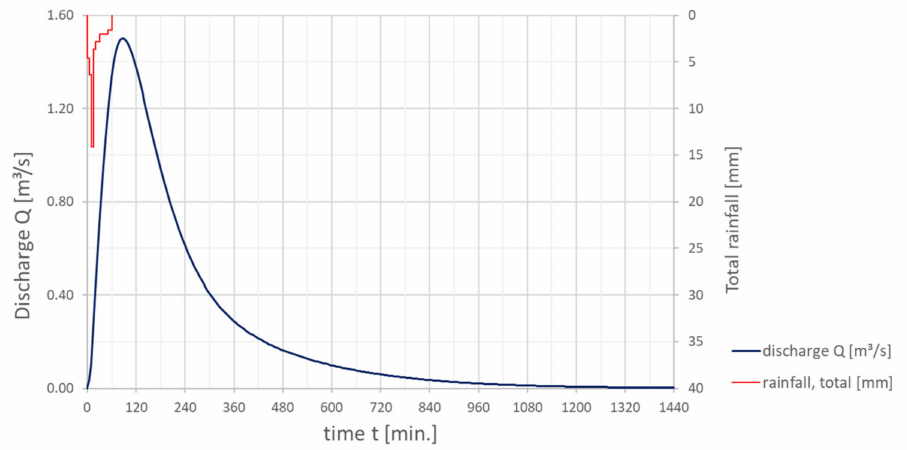
Figure 6. Determined hydrograph for the 50-year rainfall event with runoff coefficient Ψ =